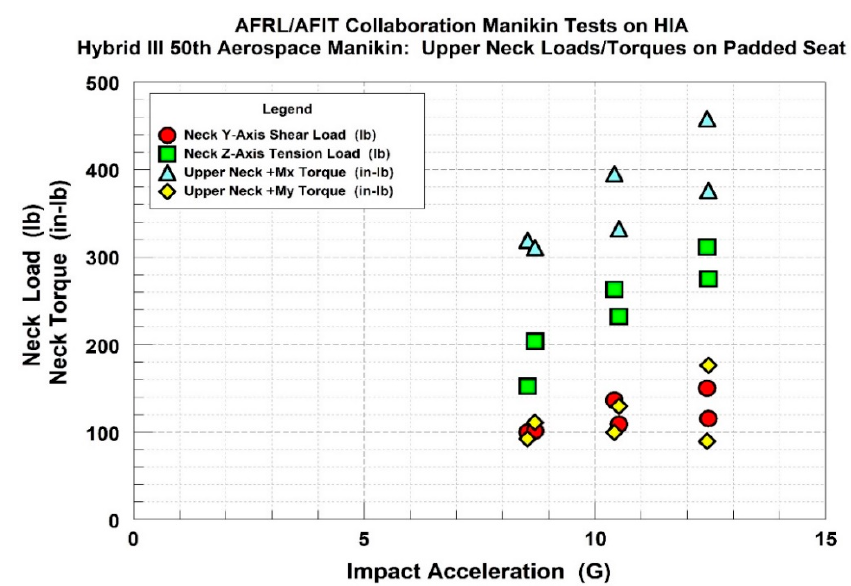
Figure 7. ATD neck responses in the padded seat. The plot shows the trend for the neck z -axis tension (axial) and neck y -axis shear (lateral) loading, and the torque around the x -axis and the y -axis, to increase linearly as a function of the impact acceleration. The tension load (squares) was much greater than the shear loads (circles), and the x-axis torque or lateral flexion (triangles) was much greater than the y-axis torque or forward flexion (diamonds).